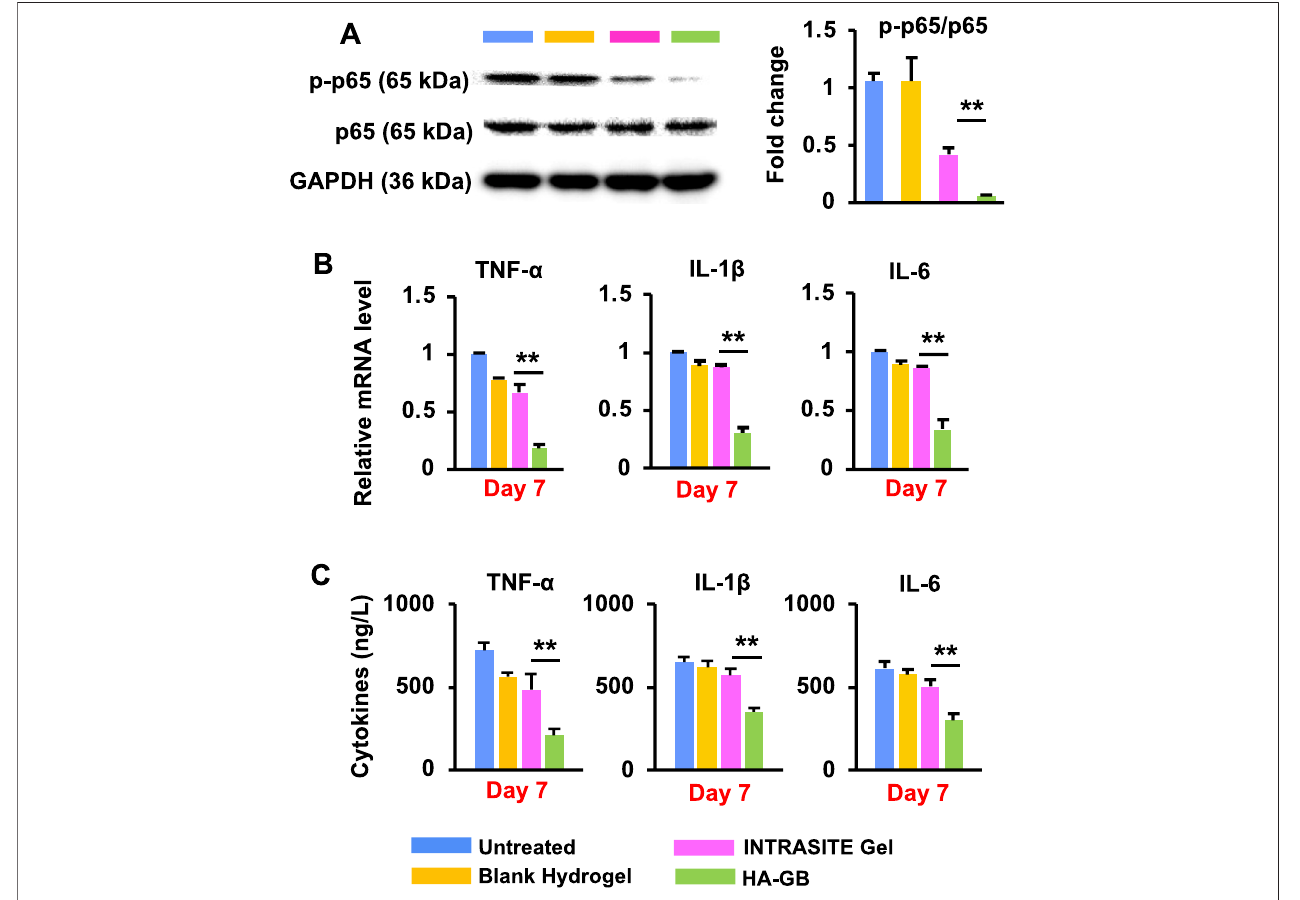
FIGURE 6 | In vivo anti-in fl ammatory effects of HA-GB. (A) The phosphorylation of p65 in diabetic wounds and the quanti fi cation of protein expression following HA-GBtreatment(1,000 μ mol/L)( n =4;** p < 0.01). (B) ThemRNAlevelofthreepro-in fl ammatorycytokines(TNF- α ,IL-1 β andIL-6)indiabeticwoundsfollowingHA-GB treatment ( n = 4; ** p < 0.01). (C) The release of three pro-in fl ammatory cytokines in diabetic wounds following HA-GB treatment ( n = 4; ** p <